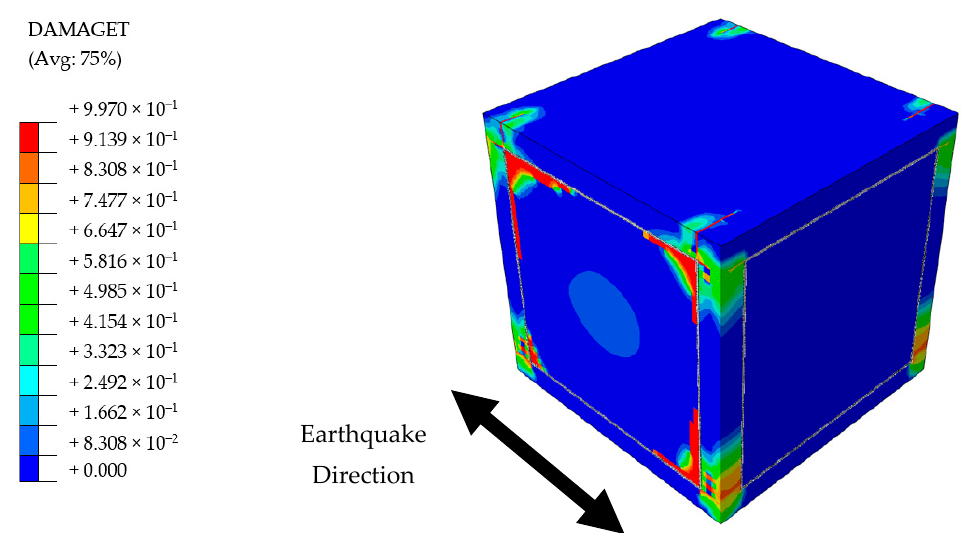
Figure 22. Damage distribution on the PUFJ Building.